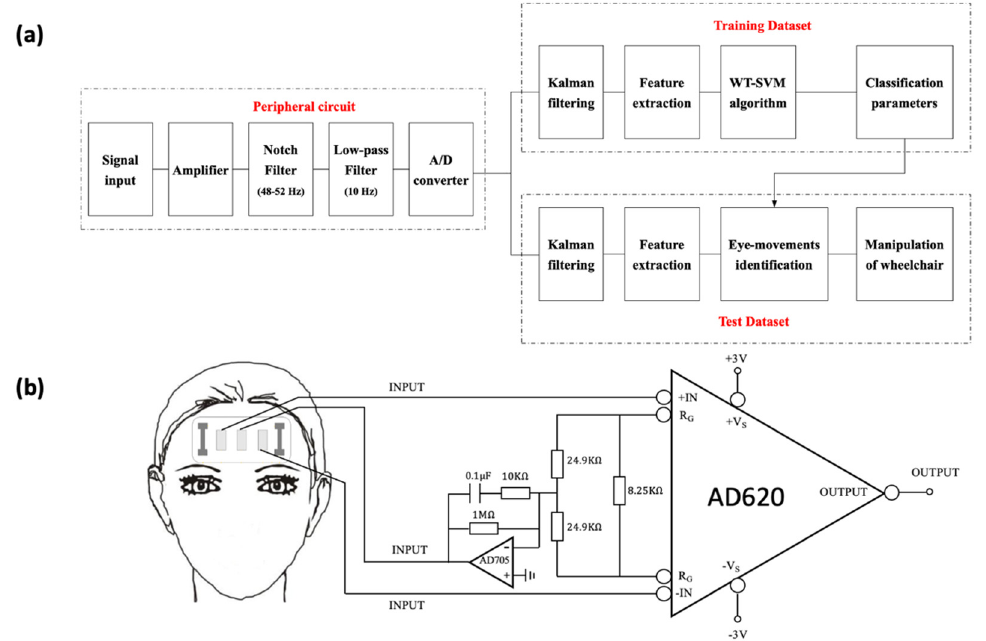
Figure 3. Processing of EOG and strain signals. ( a ) Flow chart of signal acquisition and classification. ( b ) Instrumentation amplifier.